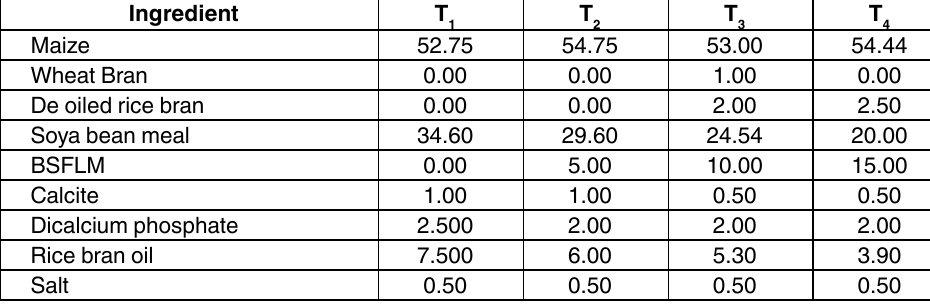
Table 3. Ingredient composition of finisher diets, per cent